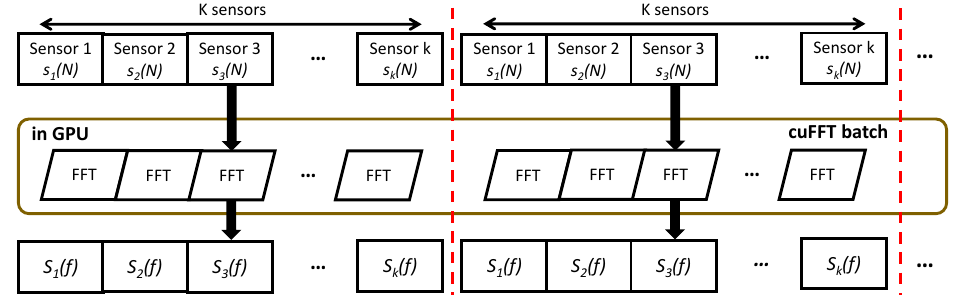
Figure 4. Parallel fast fourier transform using GPU.